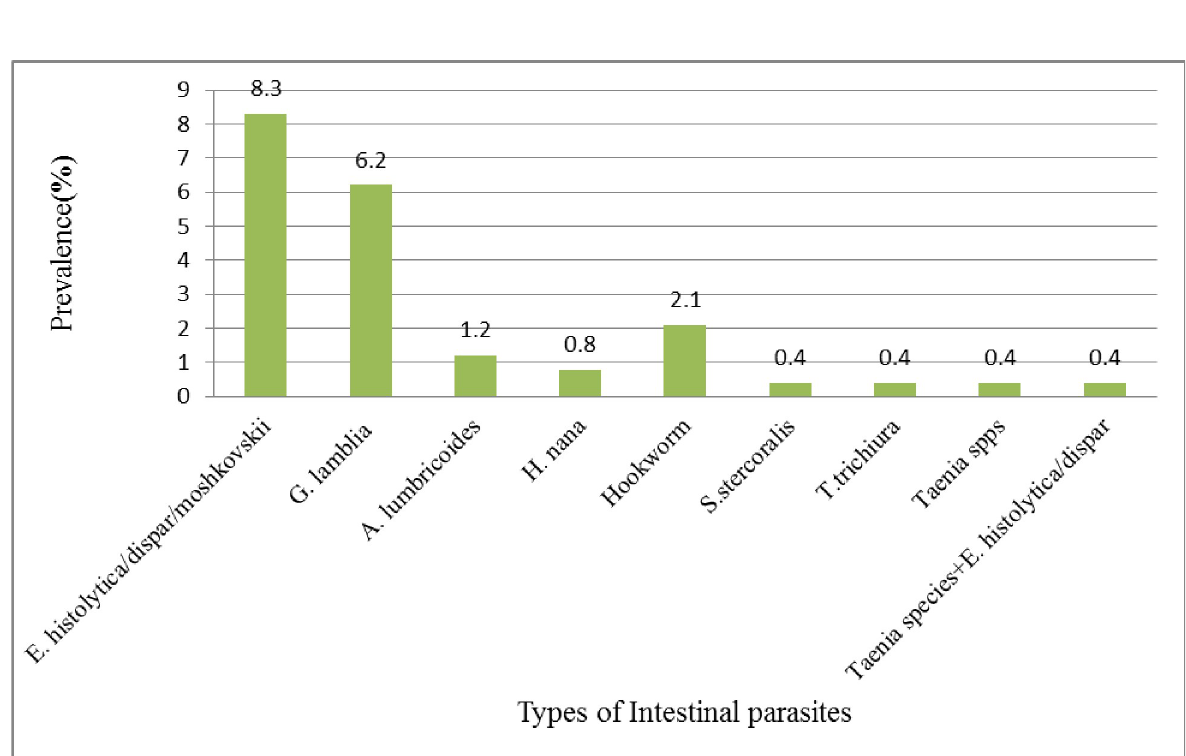
Fig 3. Parasitic infection of participants in a study of intestinal parasite among PTB patients in Kuyu General Hospital, 2020 (n = 242).